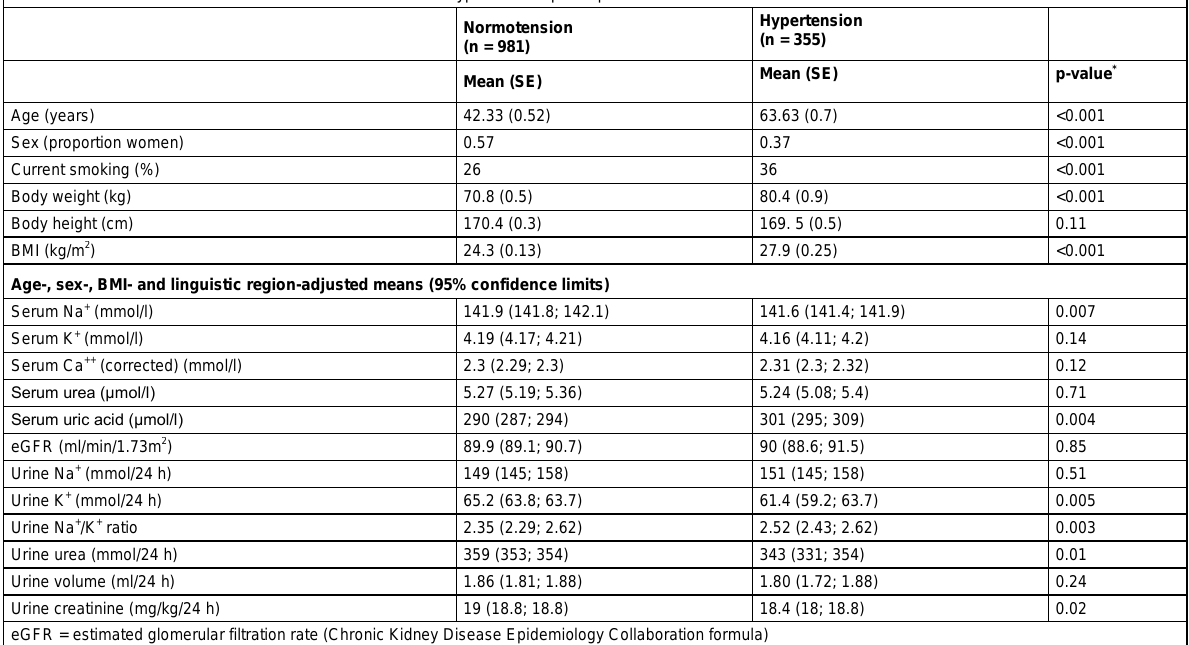
Table S2: Selected characteristics of normotensive and hypertensive participants.